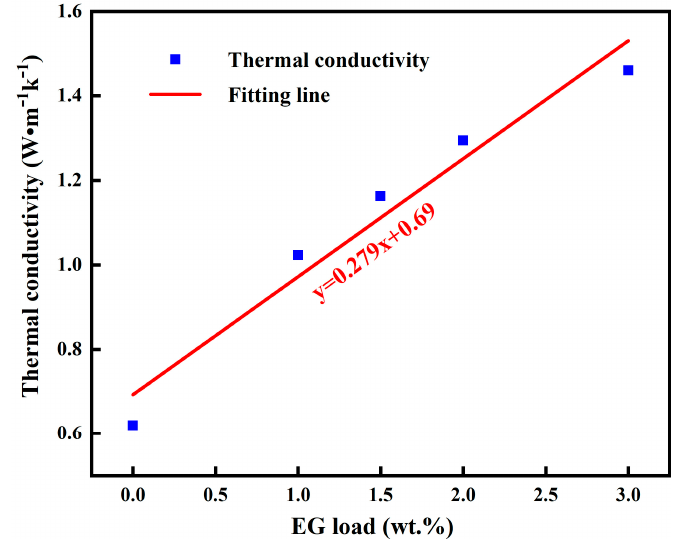
Figure 8. EG and thermal conductivity curve.